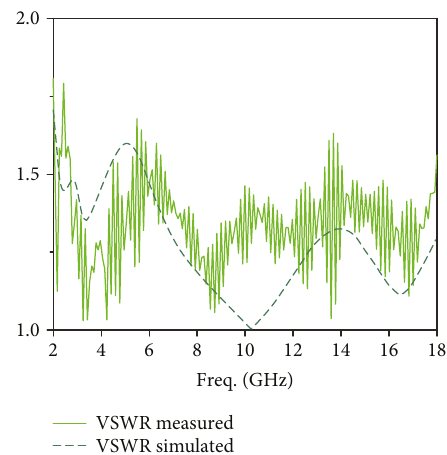
Figure 9: Comparison of measured and simulated